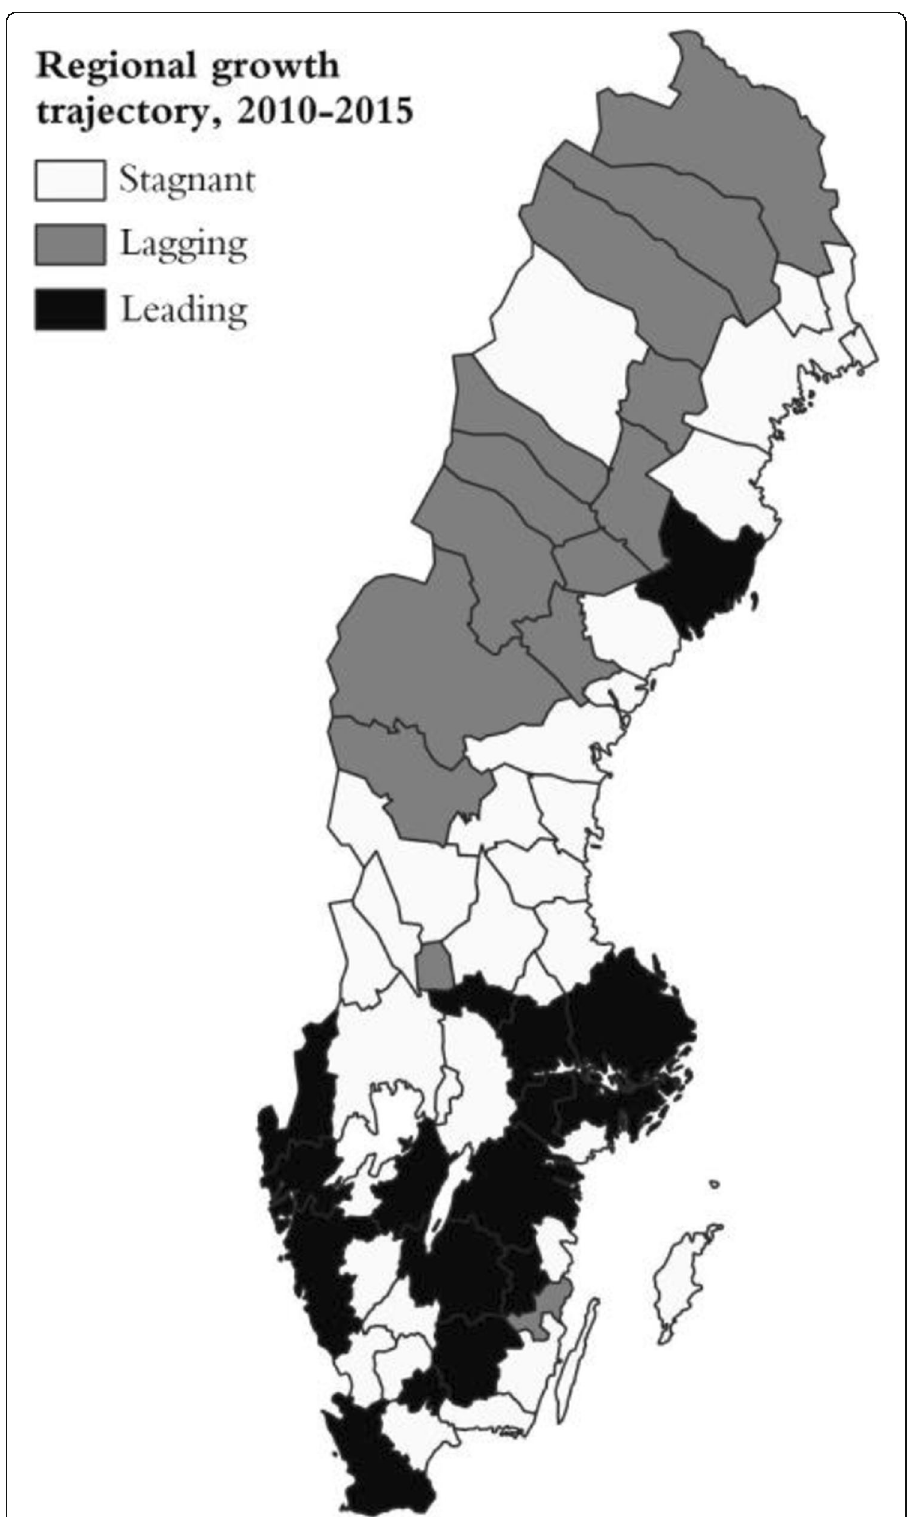
Fig. 5 Spatial distribution of lagging, stagnant, and leading regions in Sweden according to cluster analysis